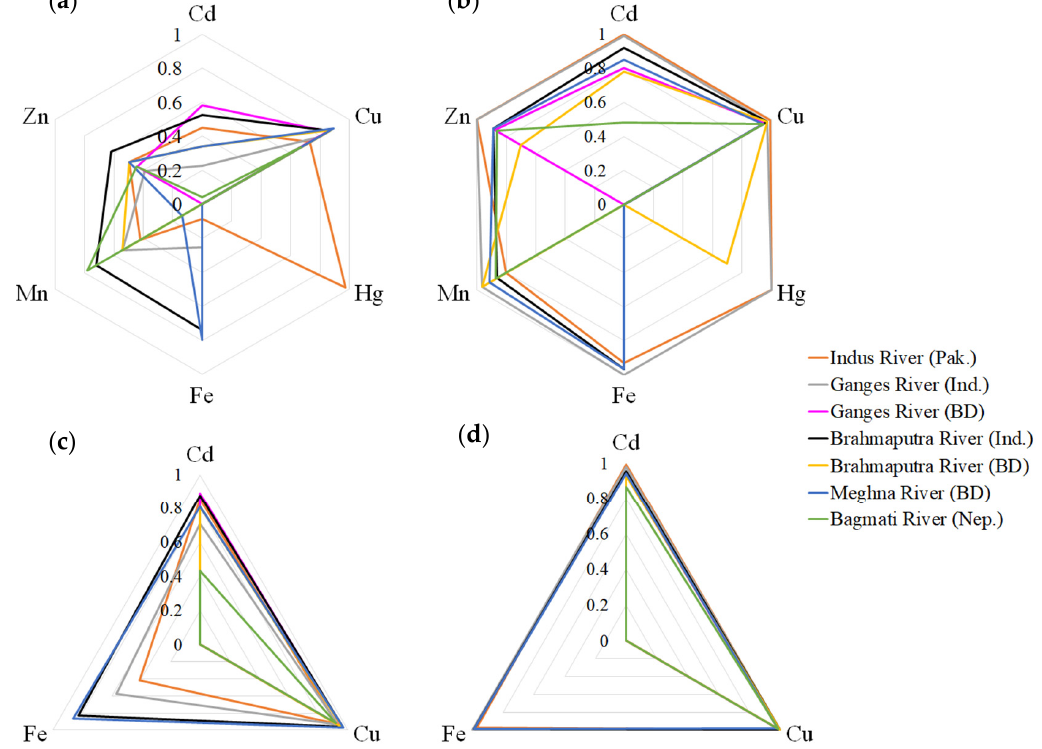
Figure 2. Spider diagram showing the trends of acute and chronic ecological risks of transition metals in different rivers (Indus River (Pakistan) (-), Ganges River (India) (-), Ganges River (Bangladesh) (-), Brahmaputra River (India) (-), Brahmaputra River (Bangladesh) (-), Meghna River (Bangladesh) (-), Bagmati River (Nepal) (-)) in South Asia. ( a ) Lowest acute PAF values of six metals in different rivers; ( b ) highest acute PAF values of six metals in different rivers; ( c ) lowest chronic PAF values of three metals in different rivers; ( d ) highest chronic PAF values of three metals in different rivers.